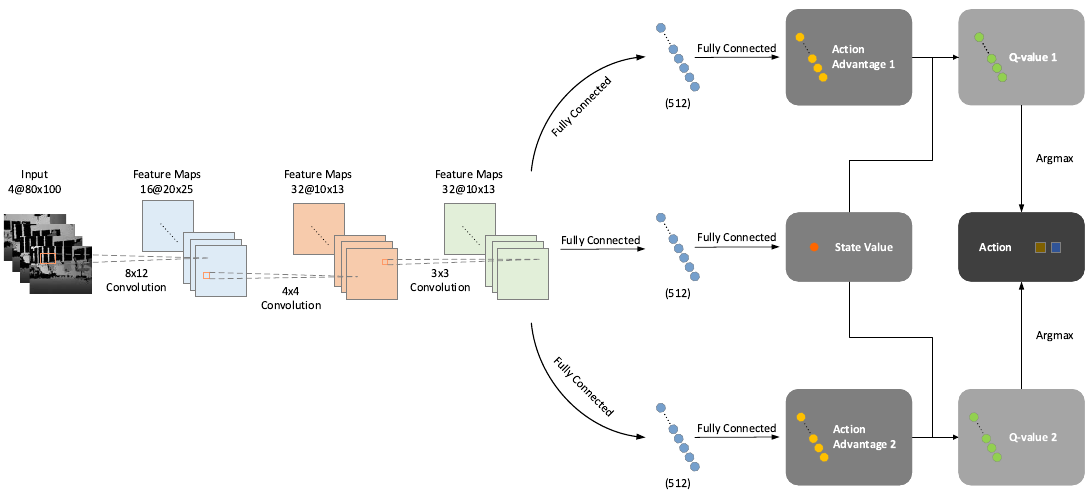
Figure 1. Network architecture of the BND-DDQN model. Input of the network is the state of the agent, which consists of a sequence of depth images from four consecutive steps. The feature representation is generated from these raw depth inputs via three convolutional layers. Subsequently, the network branches into three streams to map the feature representation to one common state value and two action advantages corresponding to linear and angular velocity commands, respectively. The action-value functions are then estimated through aggregation layers and the optimal actions are greedily